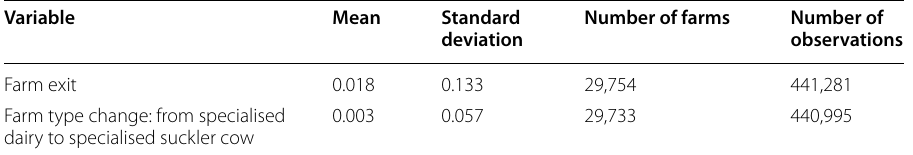
Table 3 Summary statistics of outcome variables. Source : Authors’ calculations based on AGIS